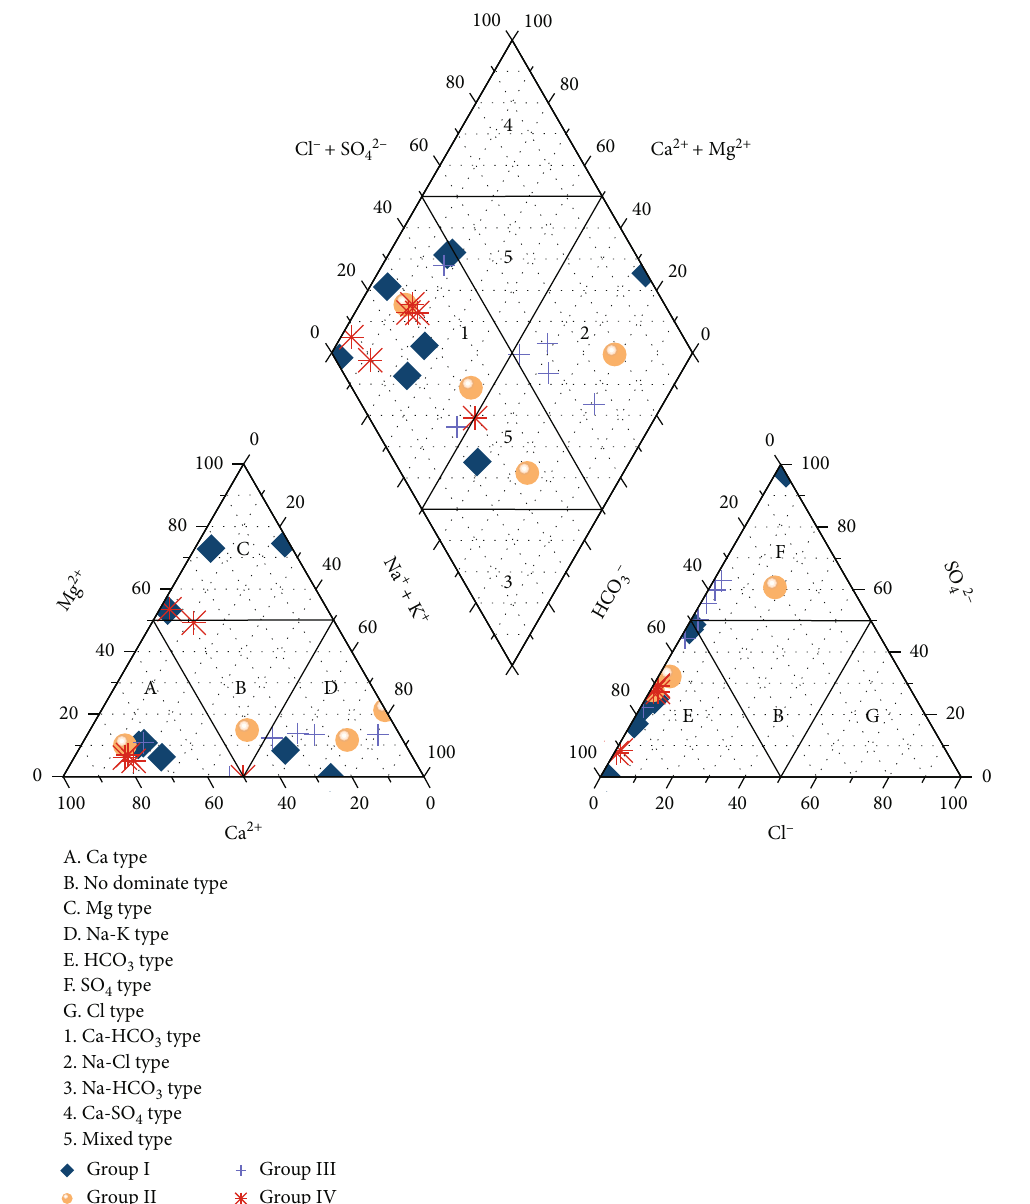
Figure 6: Piper diagram of the chemical composition of water in the study